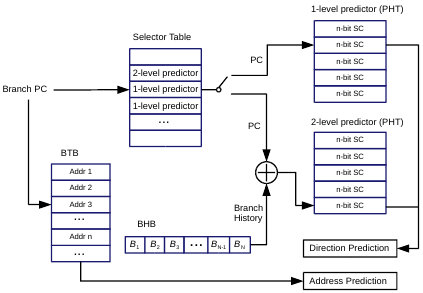
Figure 1: A demonstrating structure of the BPU with a hybrid branch predictor.